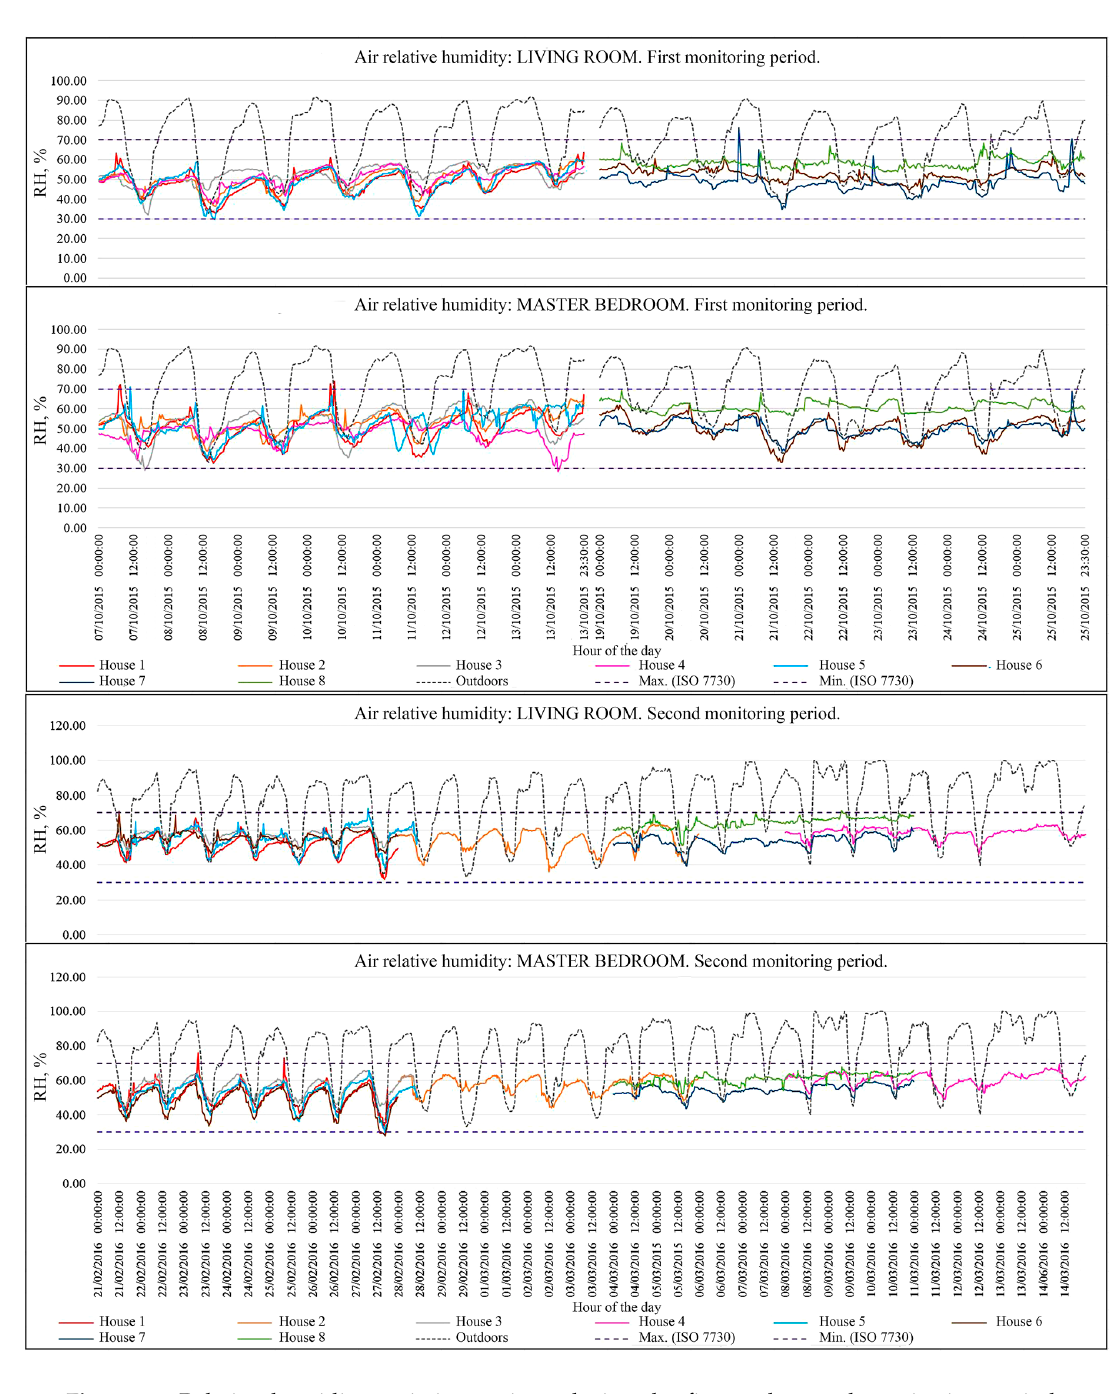
Figure 6. Relative humidity variation registry during the first and second monitoring periods (comparison of social areas, master bedrooms, external air, and ISO 7730 comfort ranks). The first monitoring period was from 7 October 2015 to 25 October 2015. The second monitoring period was from 21 February 2016 to 14 March 2016. Data from: Environmental monitoring.